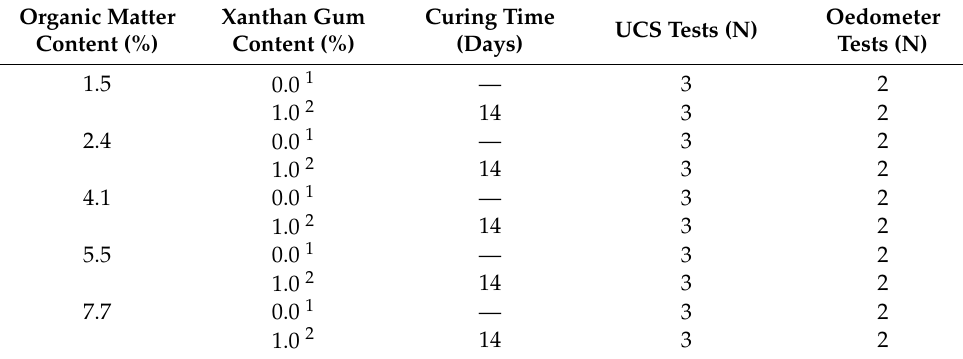
Table 1. Testing program. Number of UCS and oedometer tests carried out.